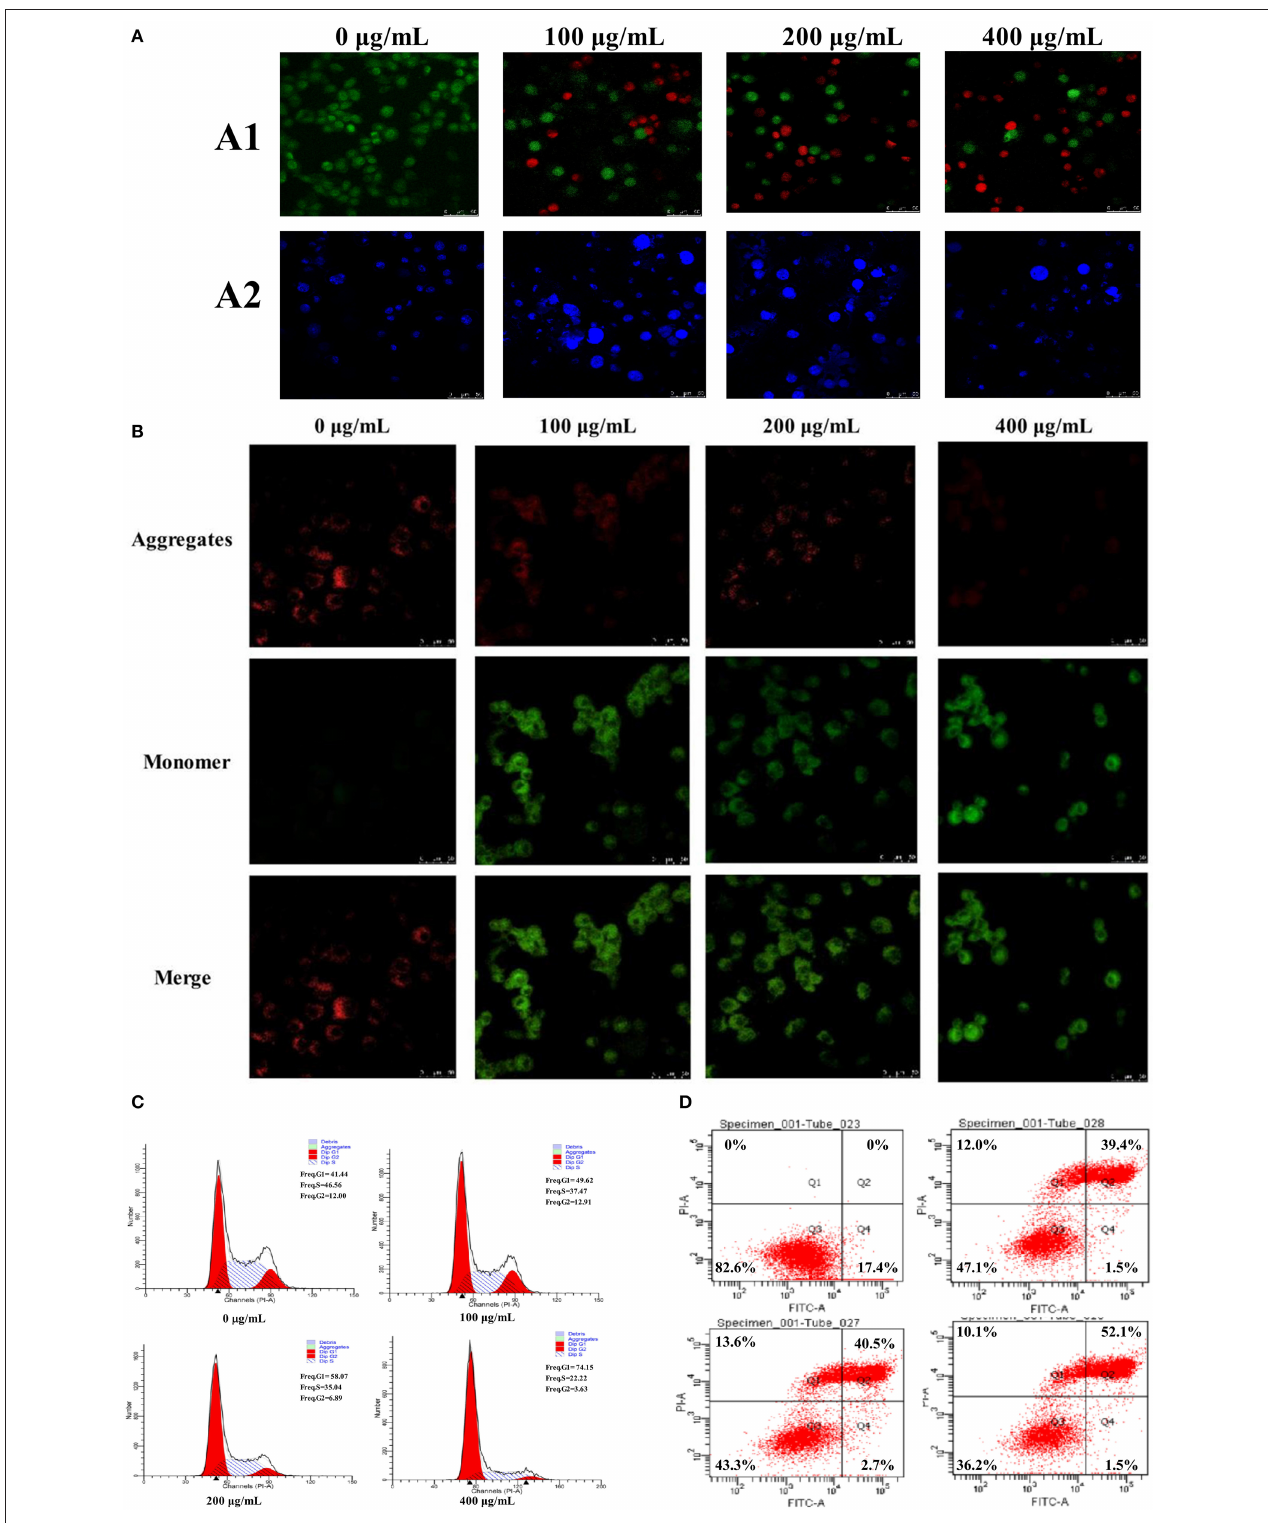
FIGURE 5 | The morphological changes of HepG2 cells treated with 0, 100, 200, and 400 µ g/mL of PSP-1 for 72h (A) , the morphological characterization of HepG2 cells was observed and photographed under a Confocal laser scanning microscope (A1) , nuclear morphological changes induced by PSP-1 in HepG2 cells after DAPI staining. (A2) Effect of PSP-1 on MMP (B) Cell cycle progression was assessed using propidium iodide staining detected by fluorescence activated cell sorting. (C) The apoptotic rates of the indicated cells induced by PSP-1 at different concentrations for 72h were detected by ANNexin V/PI double-staining asssy (D) .